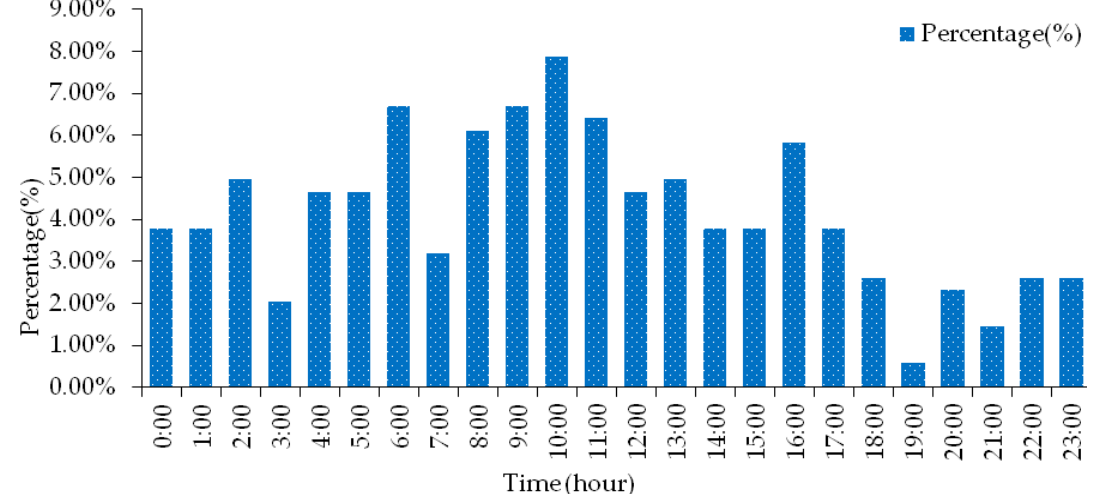
Figure 4. Time distribution characteristics of road hazardous materials transportation accidents.